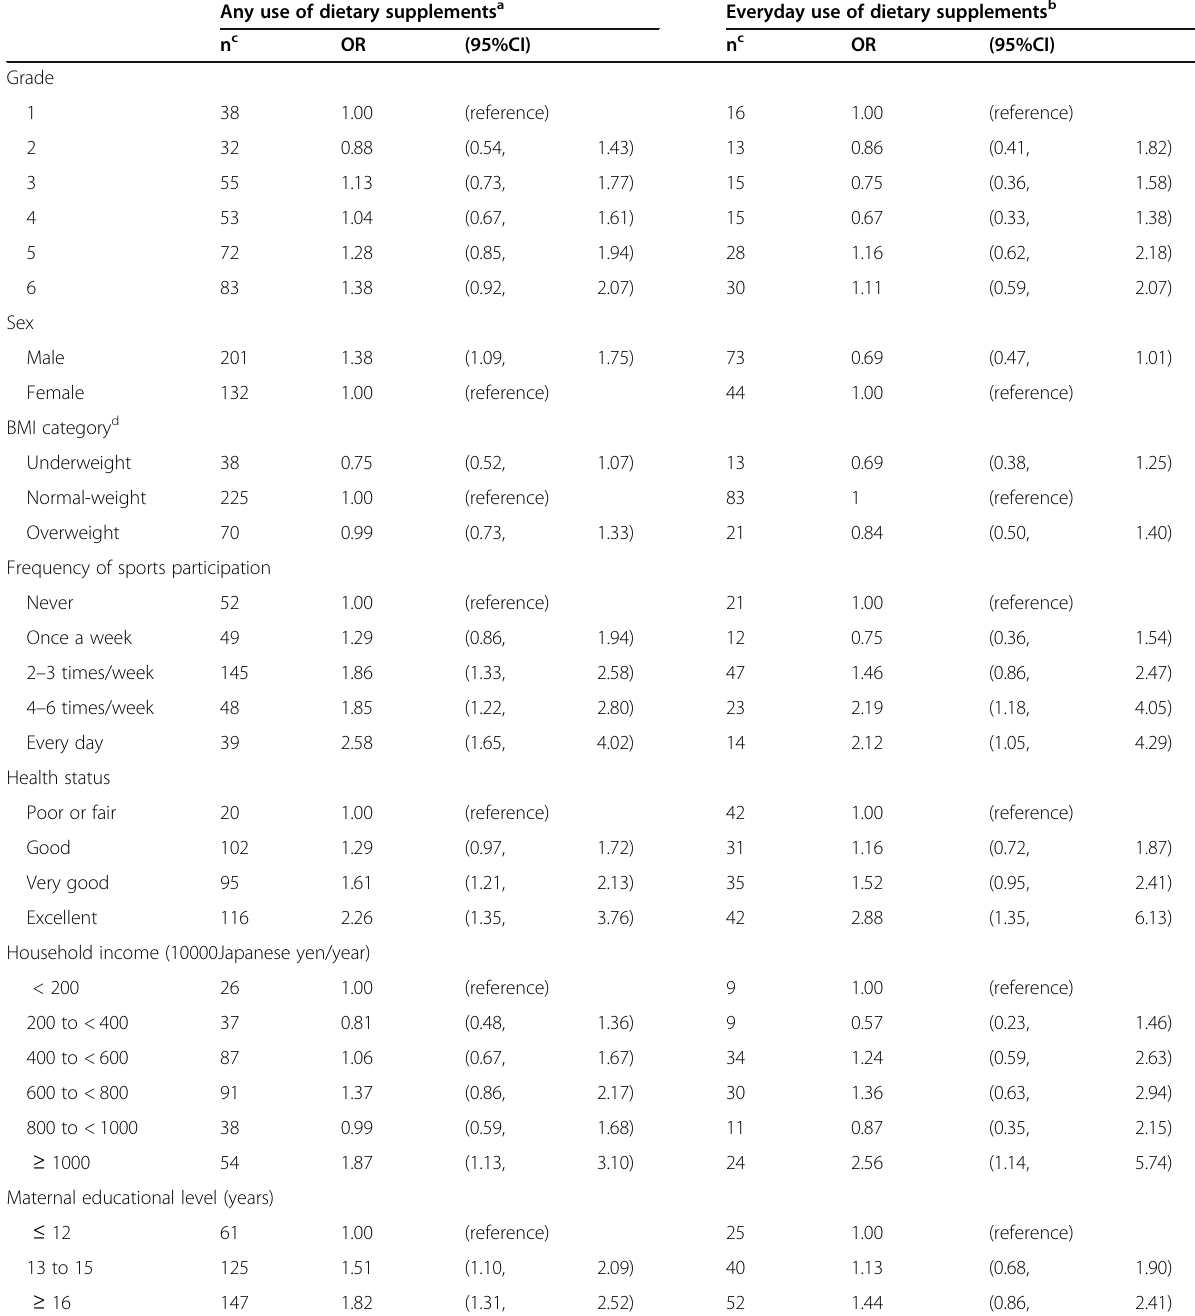
Table 3 Association between dietary supplement use and demographic, social, and health-related behavioral characteristics Any use of dietary supplements a Everyday use of dietary supplements